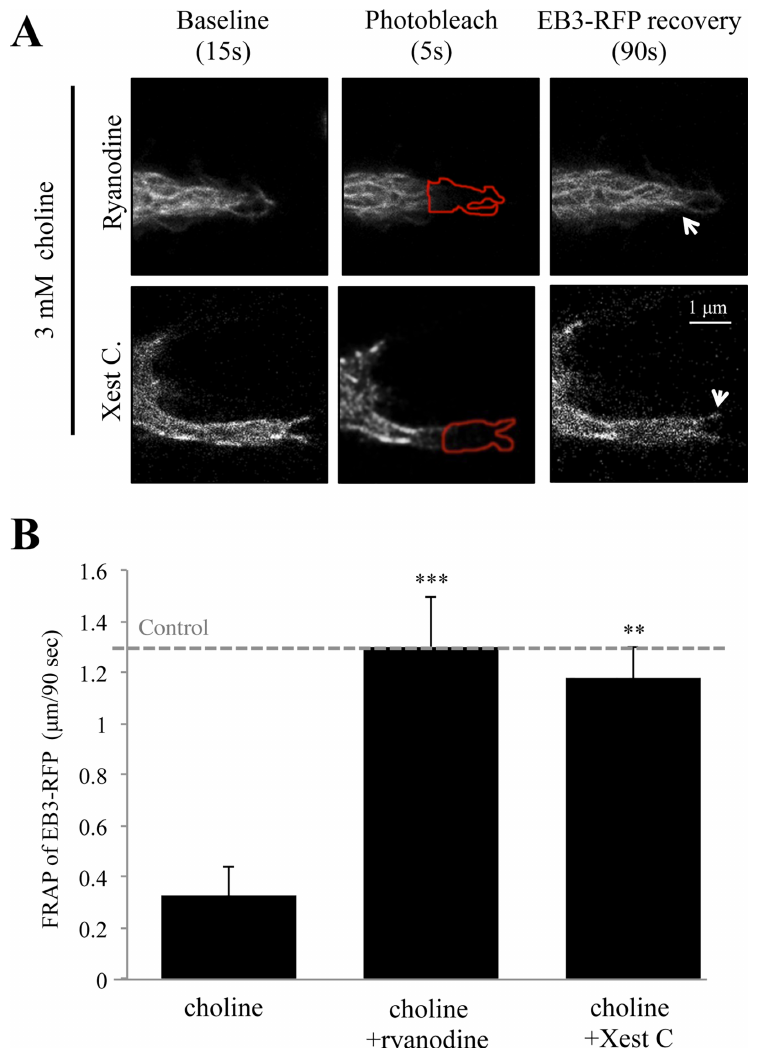
Fig 3. Intracellular calcium store release participates in choline mediated EB3 motility in the growth cone. (A) Representative images of choline mediated EB3 comet motility in ryanodine (30 μ M) and Xest C (1 μ M) pre-treated cells during the experiment. Arrows point to the location of EB3 comets recovered after photo-bleaching in the ROI indicated by a red outline. (B) Average distance traveled by EB3 comets following photo-bleaching in choline (3 mM) treated cells that were pre-incubated with 30 μM ryanodine or 1 μM Xest C. Control: EB3 comet velocity in non- treated cells. ( (cid:3)(cid:3) = p < 0.005, (cid:3)(cid:3)(cid:3) = p < 0.001; n = 18 cells per group).